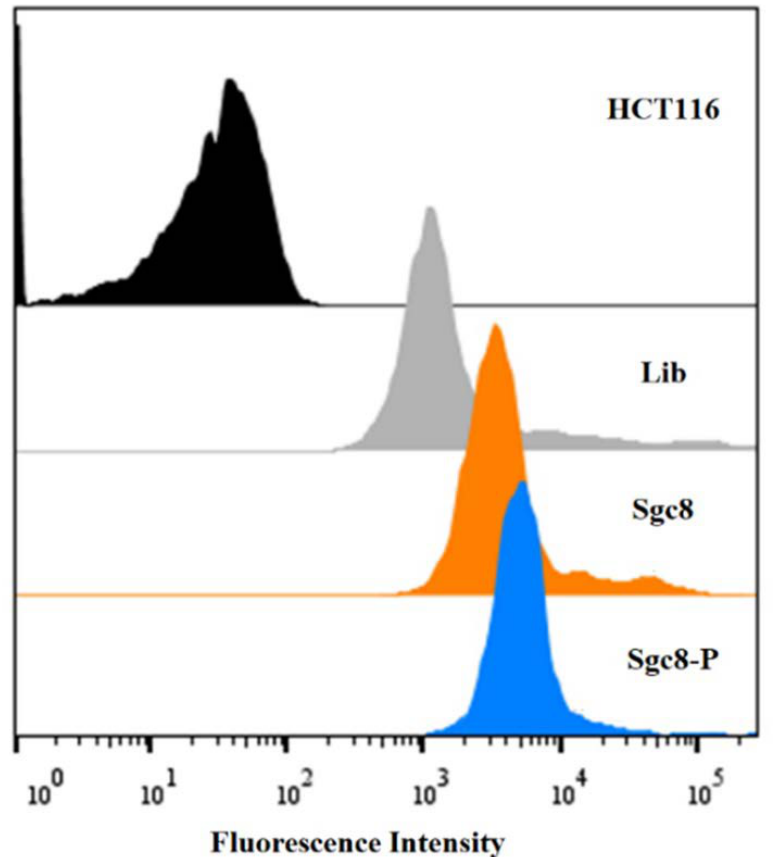
Figure 2. Flow cytometry results for HCT116 cells after incubation with 250 nM Cy5-labeled library (Lib), Sgc8, and Sgc8-P for 30 min at 4 °C. Sgc8 was used as the positive control, and Lib was used as the negative control.